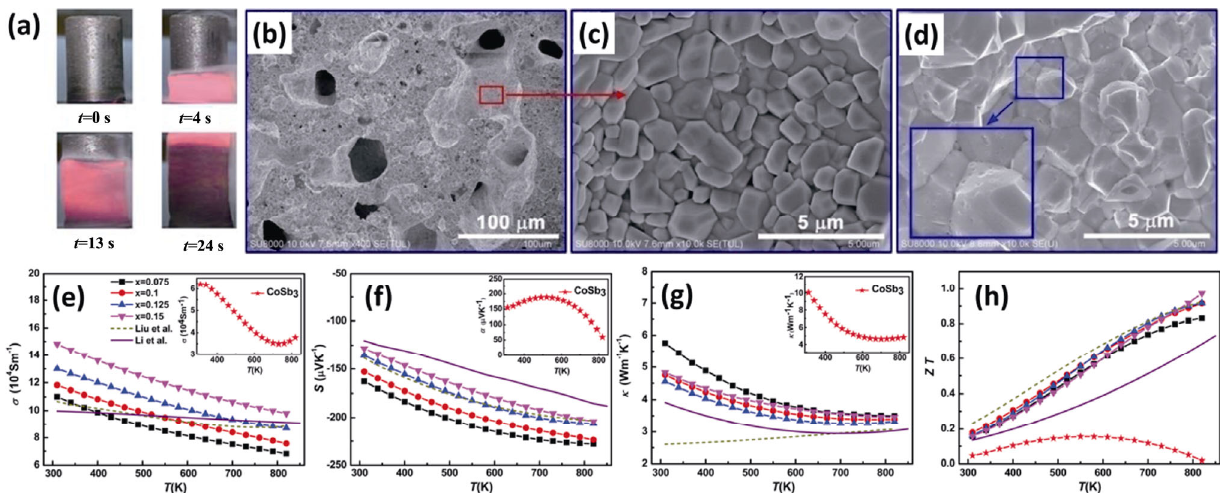
Fig. 15 Te-doped CoSb 3 materials prepared by the SHS-PAS technique. (a) Different stages of the SHS process; (b, c) FESEM images of bulk CoSb 3– x Te x compounds after the SHS process; (d) FESEM image of the bulk CoSb 3– x Te x compound after SHS-PAS processing; temperature dependence of (e) electrical conductivity, (f) Seebeck coefficient, (g) thermal conductivity, and (h) the dimensionless figure of merit ZT of CoSb 3– x Te x compounds prepared by the SHS-PAS technique. Insets in (e), (f), and (g) show TE properties of pure CoSb 3 skutterudite. Reproduced with permission from Ref. [209], © The Royal Society of Chemistry